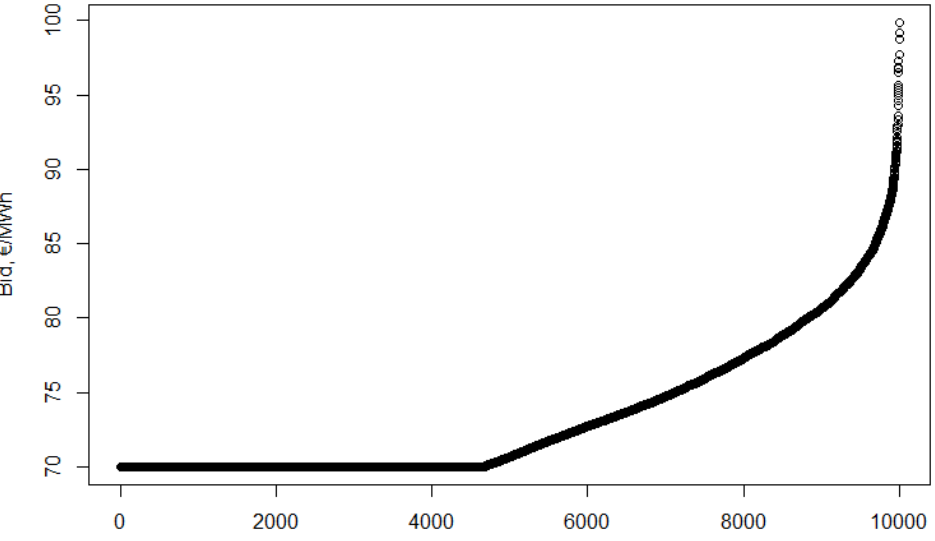
Figure A11. Sorted optimal bids assuming f N bid function, source: own figure.